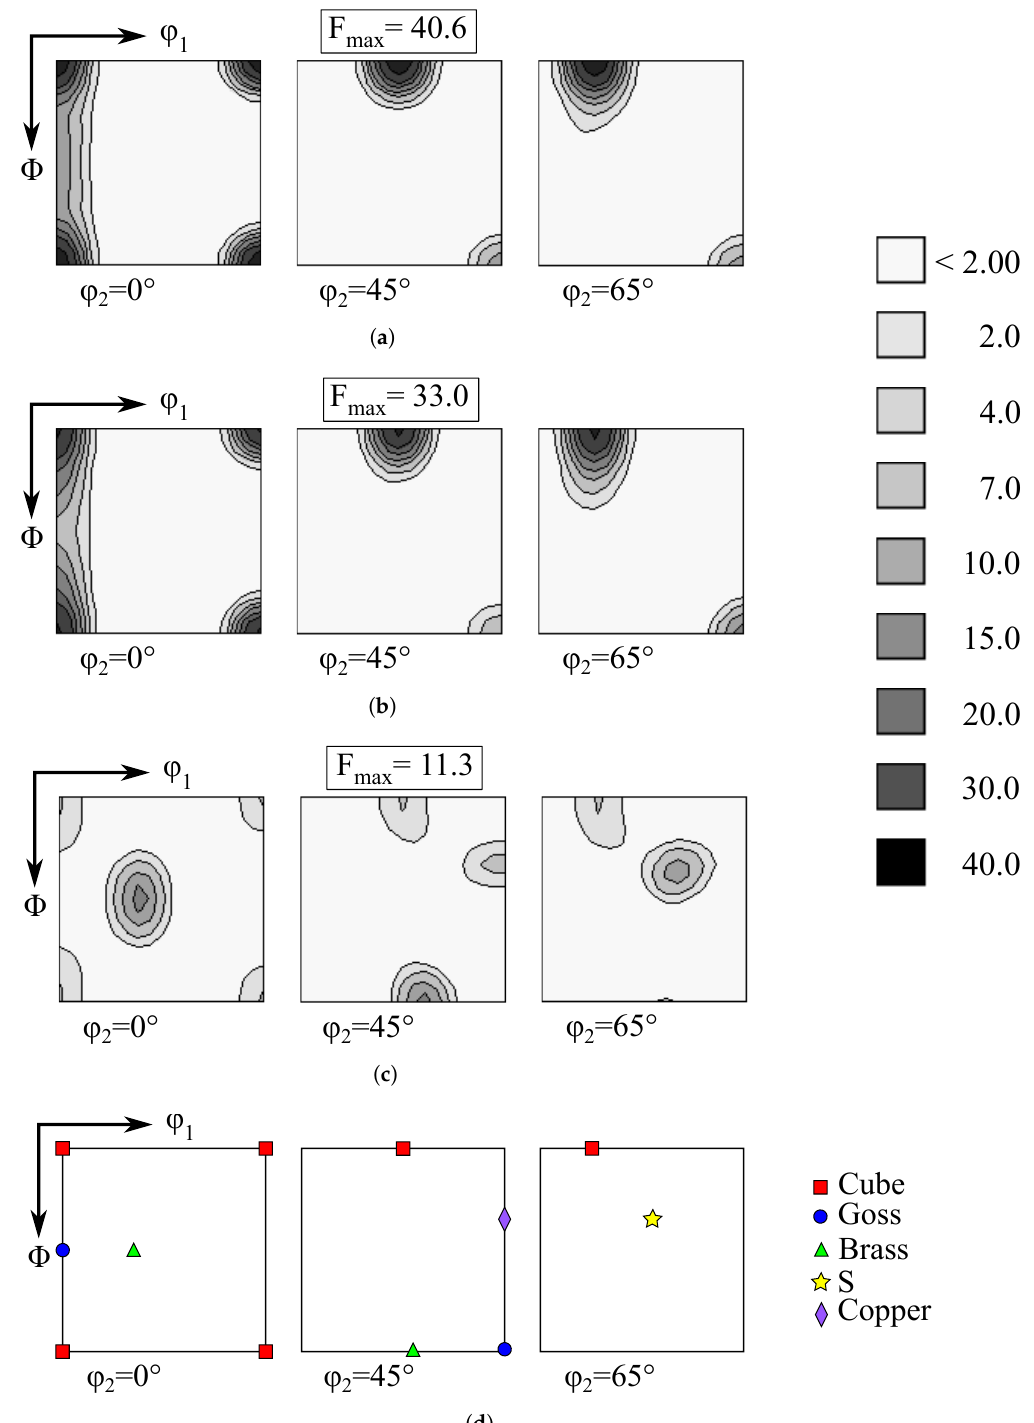
Figure 6. Orientation distribution functions (ODFs) for the alloys ( a ) AA6061, ( b ) AA6063 and ( c ) AA6110, indicating their crystallographic texture, where ( d ) show the location of the individual texture components. The scale bar gives the intensity of the function, where the maximum intensity F max of the ODF is given at the top of each